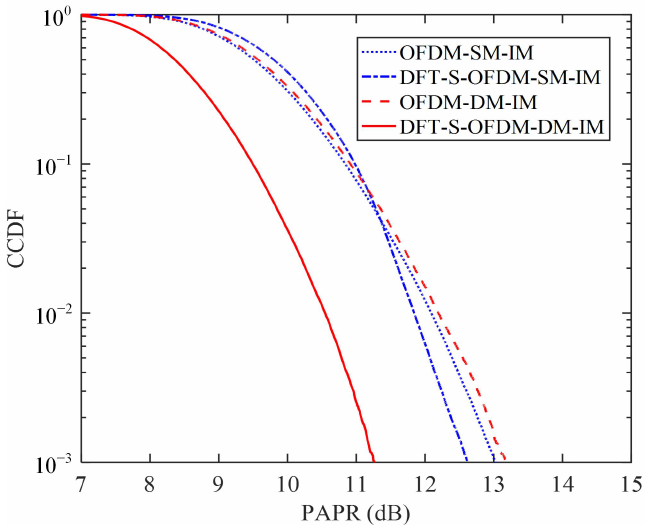
Figure 3. PAPR comparison of OFDM-SM-IM, DFT-S-OFDM-SM-IM, OFDM-DM-IM, and DFT-S-